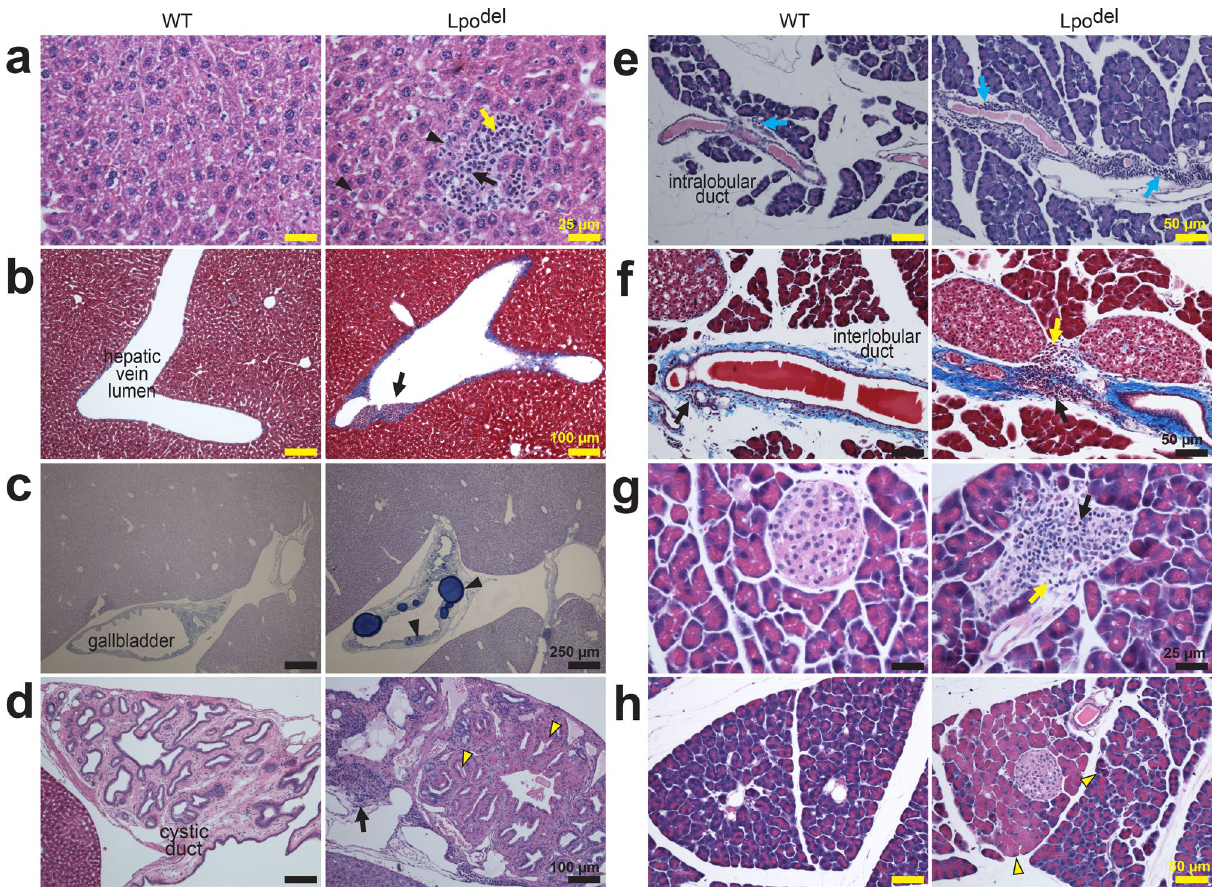
Figure 6. Histopathology in the liver, gallbladder, cystic duct and pancreas of Lpo del mice. All tissue sections of wild-type (left) or mutant (right) mice were stained by HE unless specified otherwise. ( a , b ) The mutant liver samples exhibited: (i) mononuclear (black arrow), polymorphonuclear (yellow arrow) inflammatory infiltrates and degenerative hepatocytes (black arrowheads) in the parenchyma ( a ), or primarily mononuclear infiltrates in the hepatic vascular wall (black arrows, b ); (ii) increased collagen deposition in and around the vascular wall (blue, b ). ( c ) ABPASH-stained sections of the gallbladder. In the mutant sample, accumulated acidic mucosubstance (black arrowheads) in the gallbladder epithelium was stained dark blue. ( d ) Sections of the cystic duct where the mutant sample displayed diffusive inflammatory infiltrates (black arrow) in the wall and hyaline droplets and crystals (yellow arrowheads) in the epithelium of the cystic duct. ( e – h) Pancreas sections. ( e ) Sections of the pancreas containing an intralobular duct, around which were a few mononuclear leukocytes (cyan arrow, left) in the wild-type sample but numerous inflammatory infiltrates (cyan arrows, right) in the mutant sample. ( f ) MT-stained sections of the pancreas revealing deposition of collagen (blue). There were some mononuclear leukocytes (black arrow, left) around an interlobular duct in the wild-type sample, but markedly more (black arrow, right) in the mutant sample with scattered polymorphonuclear leukocytes (yellow arrow, right). ( g ) Sections containing pancreatic islets of Langerhans where the islet in the mutant sample was infiltrated by numerous mononuclear (black arrow) and polymorphonuclear (yellow arrow) leukocytes. ( h ) Sections of the pancreas where the mutant sample exhibited a patch of swollen acinar cells with hypereosinophilic cytoplasm and apparent pyknotic nucleus (yellow arrowheads). Scale bars are 25 µm ( a , g ); 50 µm ( e , f , h ); 100 µm ( b , d ); 250 µm ( c